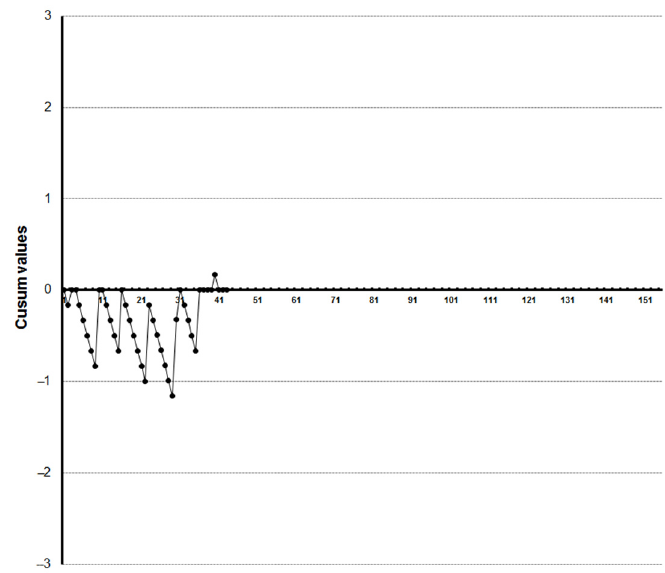
Figure 9. LC-CUSUM curve for trainee five. This trainee did not reach competence.